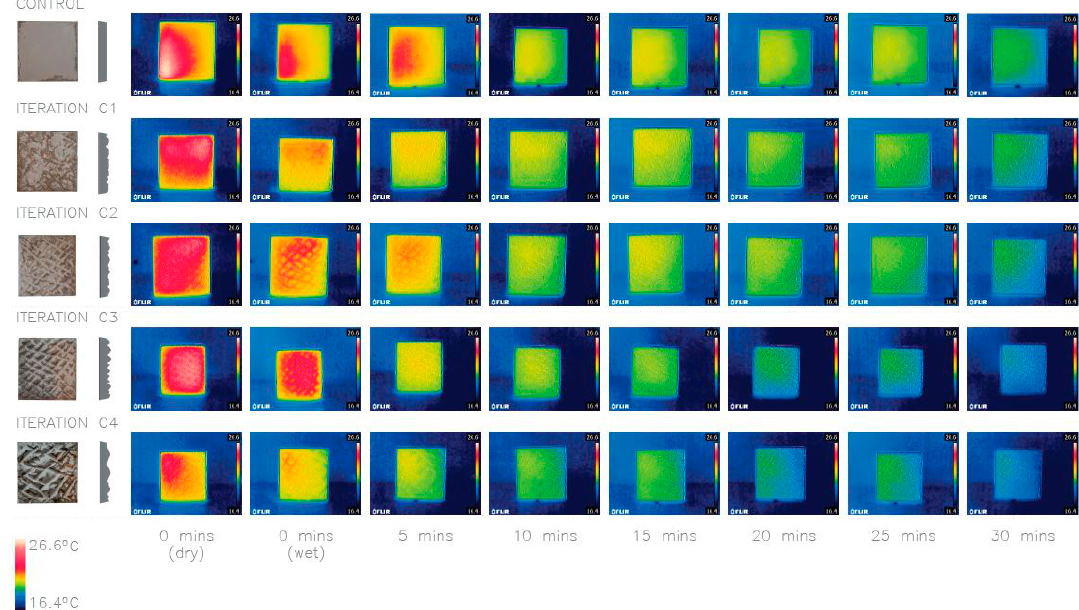
Figure 4. Thermal images of investigation 1: comparison of five concrete panels with different texture depths (d) and scale (s) and SA:V ratios. Control: plane (1.07 SA:V); C1: d–2.5 mm s–1 (1.16 SA:V); C2: d–5 mm s–1 (1.25 SA:V) C3: d–10 mm s–1 (1.33 SA:V); C4: d–10 mm s–2 (1.18 SA:V). Average heat loss after 30 min: Control 6.3 °C, C1 6.5 °C, C2 6.6 °C, C3 7.6 °C, C4 6.7 °C.